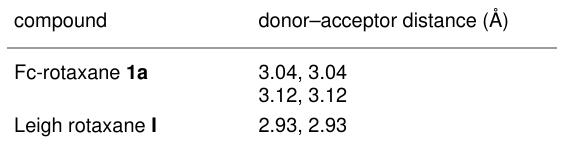
Table 1: Selected H···O distances from the solid-state structures.